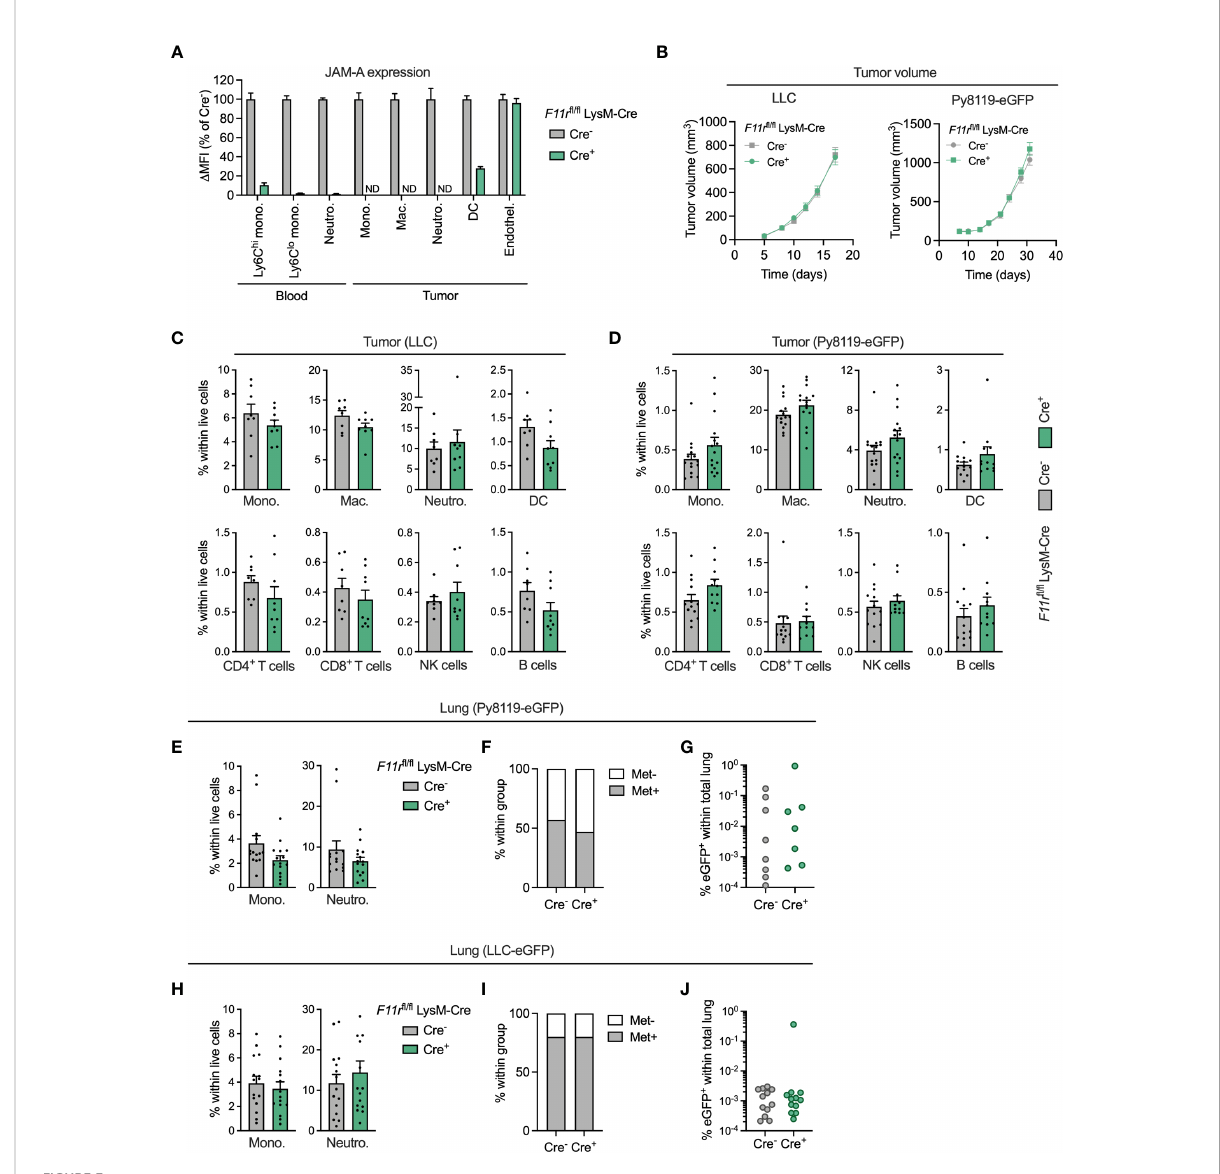
FIGURE 3 JAM-A is dispensable for myeloid cell accumulation in the primary tumor and in the pulmonary metastatic site. (A) JAM-A expression in myeloid cell populations and endothelial cells in LLC tumors of F11r fl ox/ fl ox LysM-Cre + mice normalized to F11r fl ox/ fl ox LysM-Cre - mice. ND = not detected. Day 17 post-engraftment, tumor volume shown in panel (B) . (B) LLC (n=16-17) and Py8119-eGFP (n=14-15) tumor growth in F11r fl ox/ fl ox LysM-Cre - and F11r fl ox/ fl ox LysM-Cre + mice. (C) Frequency of indicated myeloid and lymphoid cell populations in LLC tumors (n=9-10). Day 17 post-engraftment, tumor volume is shown in panel (B) . (D) Same as (C) in Py8119-eGFP tumors (n=12-13). Day 31 post-engraftment, tumor volume is shown in panel (B) . (E) Frequency of monocytes and neutrophils in the lungs of tumor-bearing mice with Py8119-eGFP tumors (n=14-15). Panel E-G: Day 31 post-engraftment. (F) Proportion of mice with eGFP + metastatic Py8119 cancer cells in the lung detected via fl ow cytometry. (G) Frequency of eGFP + metastatic cancer cells in the lungs of Py8119-eGFP tumor-bearing mice (n=14-15). (H – J) Same as (E – G) for LLC-eGFP tumors (n=15). Day 17 post-engraftment. JAM-A expression and cell frequencies were determined using fl ow cytometry. All graphs show mean and